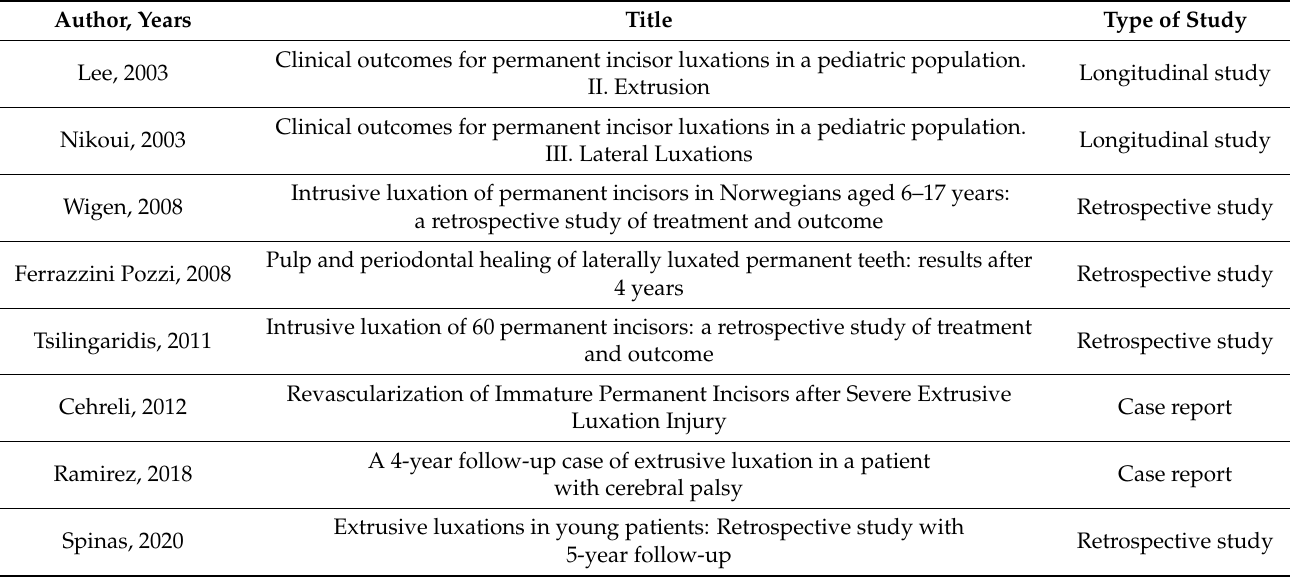
Table 3. The table summarizes the main characteristics of the studies included in the review.